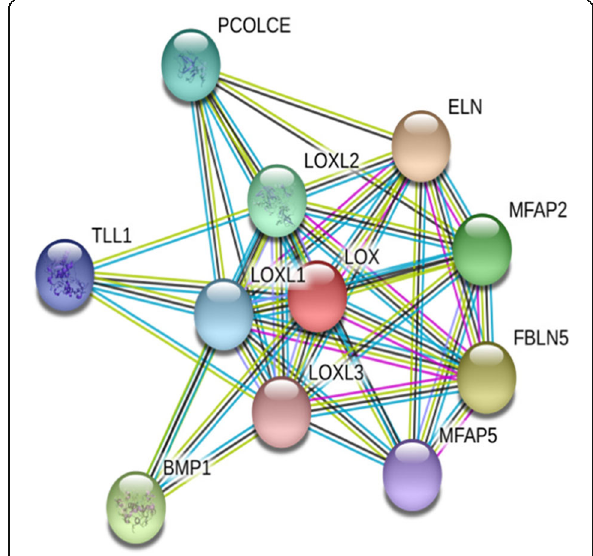
Fig. 9 Protein-protein interaction map of canine lysyl oxidase protein by STRING web server. The closest interacting protein having the shortest node was found elastin while the distant interacting protein was lysyl oxidase-like 3 and microfibrillar-associated protein 5